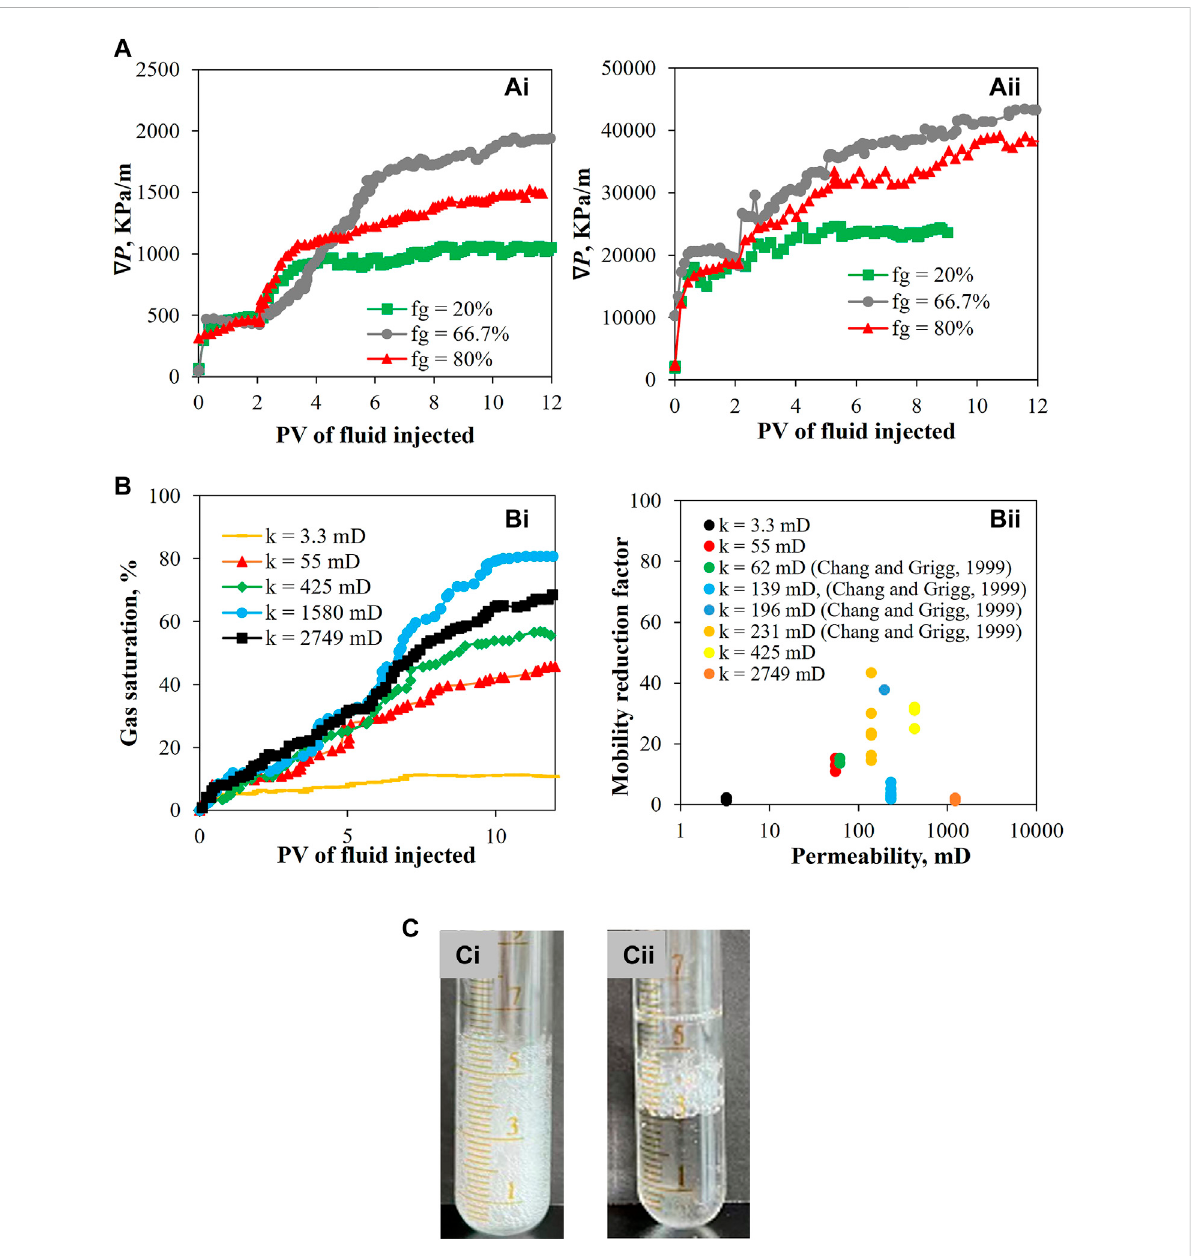
FIGURE 3 (A) Pressure difference evolution over the course of core fl ooding experiments in cores with permeabilities of (Ai) 3.3 mD, and (Aii) 425 mD, respectively. (Bi) Gas saturation evolution for foam fl ow experiments with different core permeabilities. (Bii) Steady-state mobility reduction